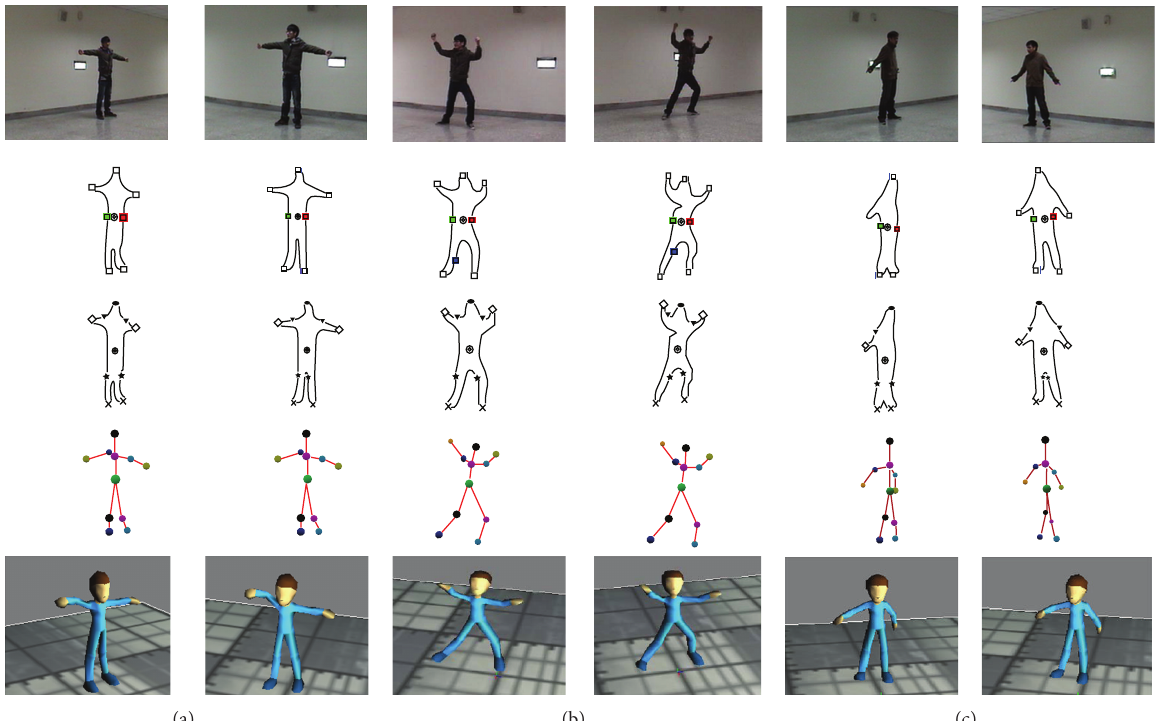
Figure 11: Experimental results of standing postures with hands and/or feet bending in Experiment 2, where notations of the points are listed as follows. 2nd row: convex points on the contour ( ◻ ), COG ( ⊚ ), and the intersection points of the major and minor axes with the contour ( ◼ ). 3rd row: head (“ ∙ ”), the tips of the feet (“ × ”), the tips of the hands (“ ◊ ”), the elbows (“ 󳶃 ”), and the knees (“ 󳀅